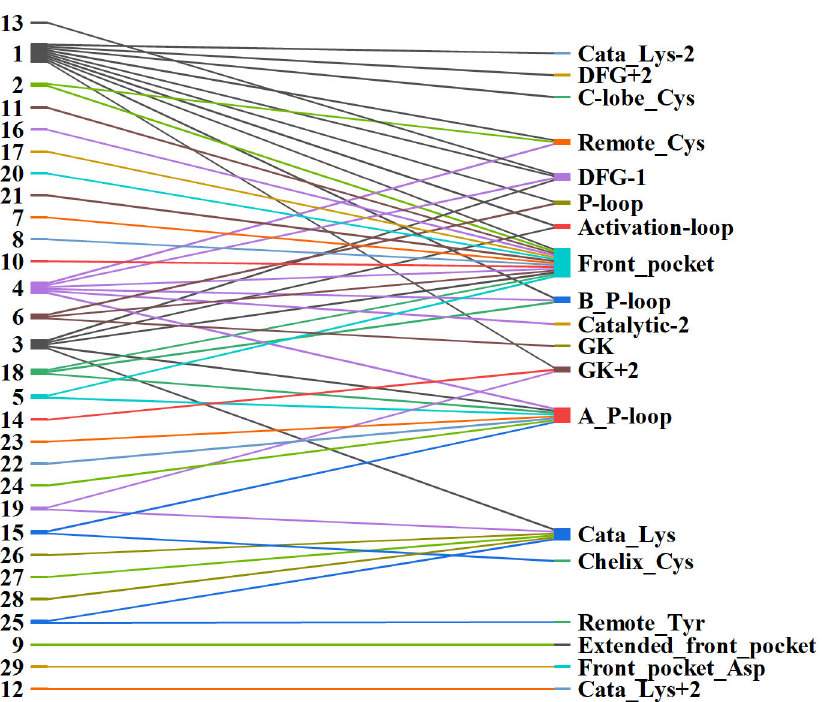
Figure 5. Warheads and their kinase binding sites.